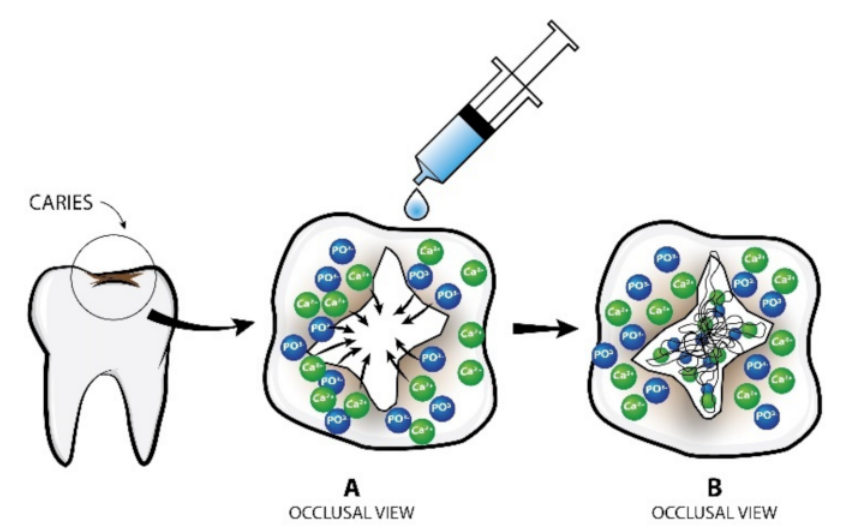
Figure 1. Mode of action of P11-4 on dental caries. ( A ) Calcium hydroxyapatite crystals around the lesion are attracted inwards and interact with peptide molecules; ( B ) Formation of new hydroxyapatite crystals within the scaffold